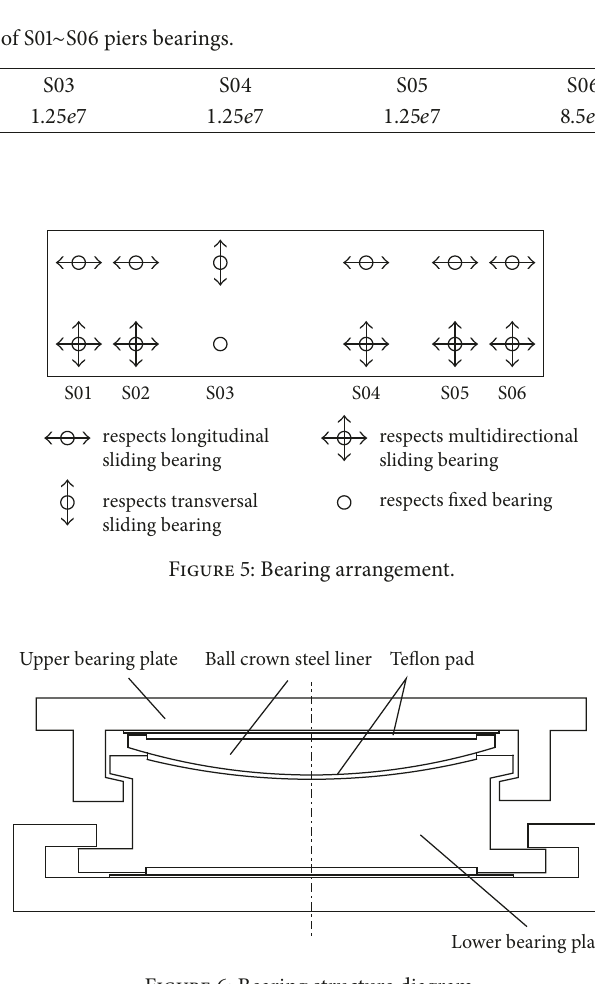
Figure 6: Bearing structure